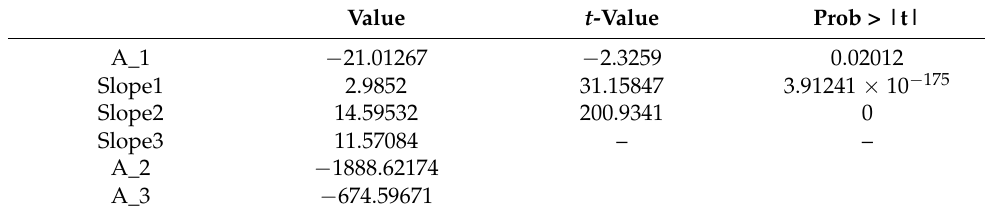
Table 5. Test parameters for significance of fitting curve (red curve) of Figure 12b.